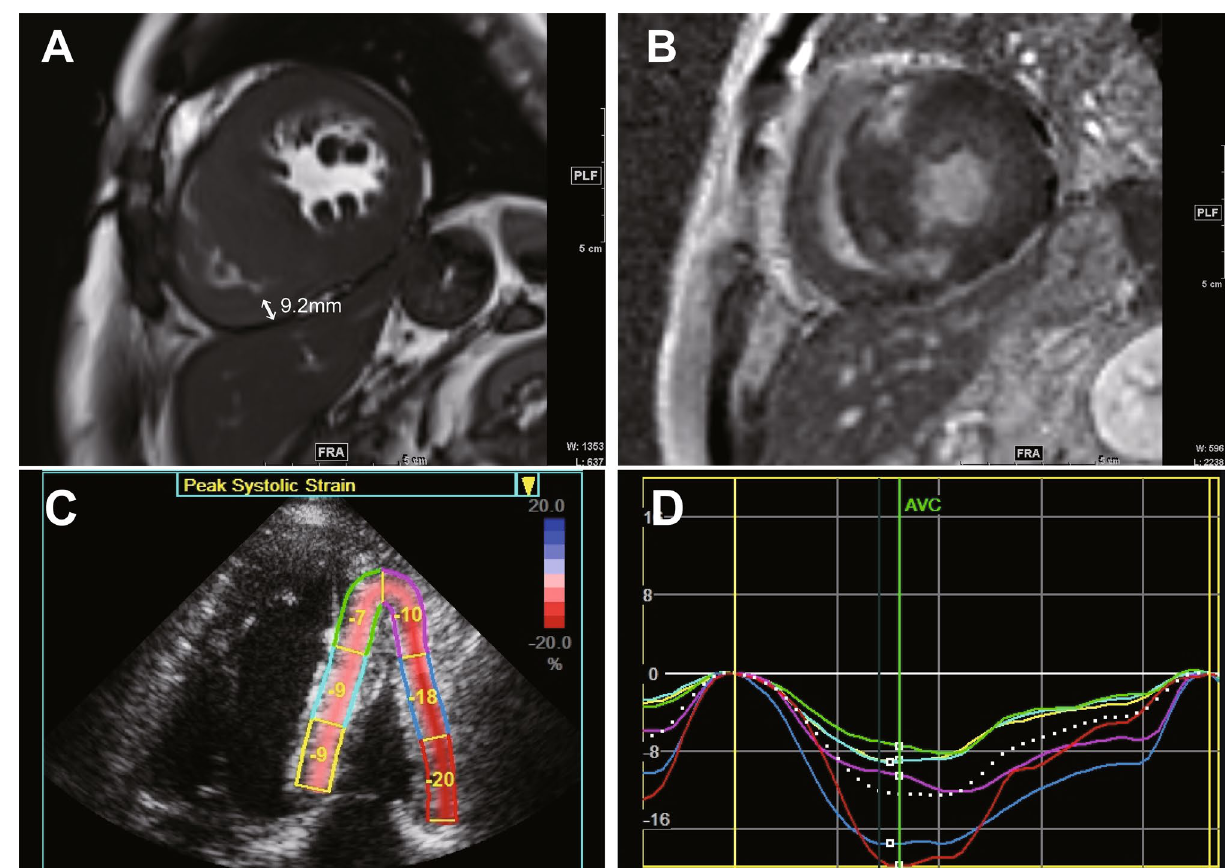
Figure 1. Representative case of HCM with RV involvement. (A) Significant hypertrophy of the RV apex (9.2 mm) and (B) late gadolinium enhancement in the anteroseptal and inferoseptal wall were seen. (C,D) Impaired right ventricular two-dimensional speckle-tracking strain pattern is seen in the patient. Longitudinal